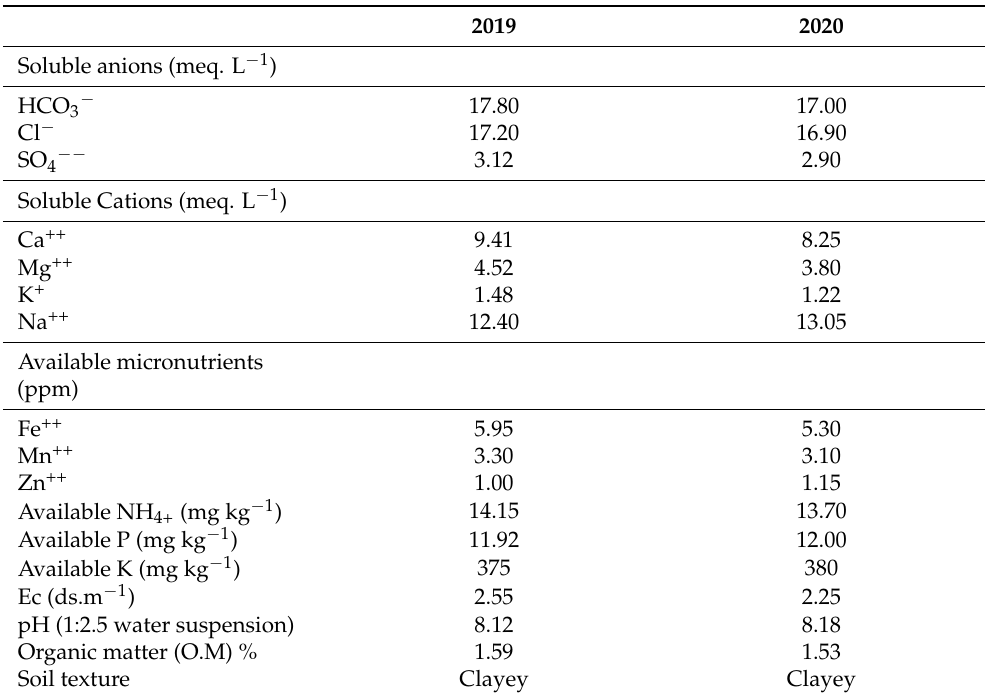
Table 1. Soil chemical properties of the experimental sites in the 2019 and 2020 seasons.